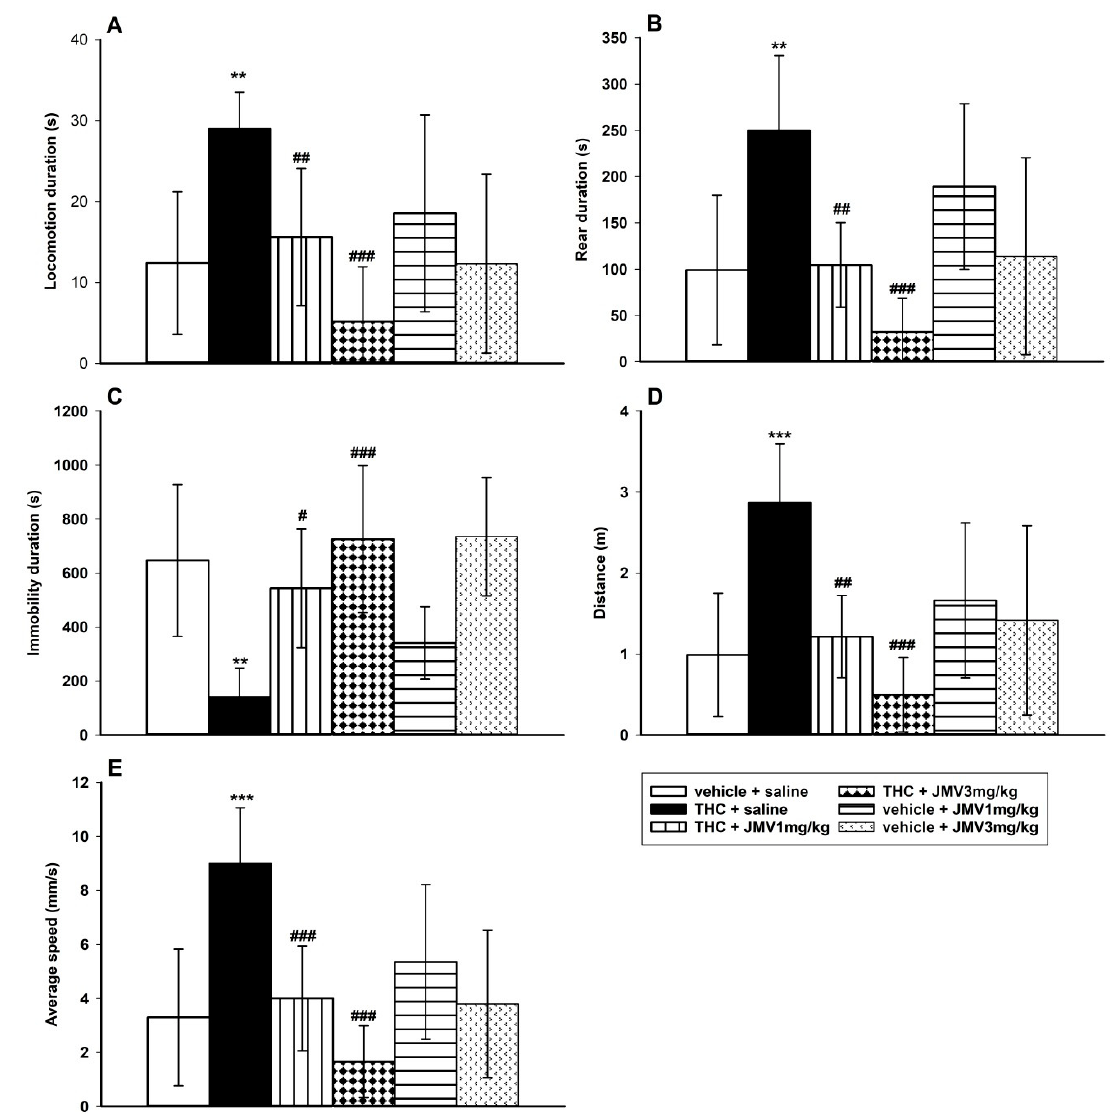
Figure 2. Effects of JMV2959 on the THC-induced behavioral changes in rats in the LABORAS cage. JMV2959 (0, 1, 3 mg/kg i.p.) was administered immediately before placing the rats into the cage and after 20 min of habituation, a stimulatory THC dose 0.1 mg/kg or saline was administered intraperitoneally. After another 20 min of habituation, behavior monitoring started and lasted for 20 min (20–40 min after THC administration). Changes in locomotion duration ( A ), rear duration ( B ), immobility duration ( C ), distance traveled ( D ), and average speed overall ( E ) are illustrated as follows: saline + vehicle (open bar) ( n = 9), saline + THC (filled bar)( n = 7),1 mg/kg + THC (vertically striped bar)( n = 8), JMV2959 3 mg/kg + THC (diamond bar)( n = 8), JMV2959 1mg/kg + vehicle (horizontally striped bar)( n = 4), JMV2959 3 mg/kg + vehicle (little arrows bar)( n = 8). The JMV2959 pretreatment effects in comparison to saline + THC group are expressed as # p < 0.05, ## p < 0.01, ### p < 0.001. Differences between groups in comparison to vehicle + saline group are expressed as ** p < 0.01, *** p < 0.001. The results are presented as group means with 95% confidence intervals.